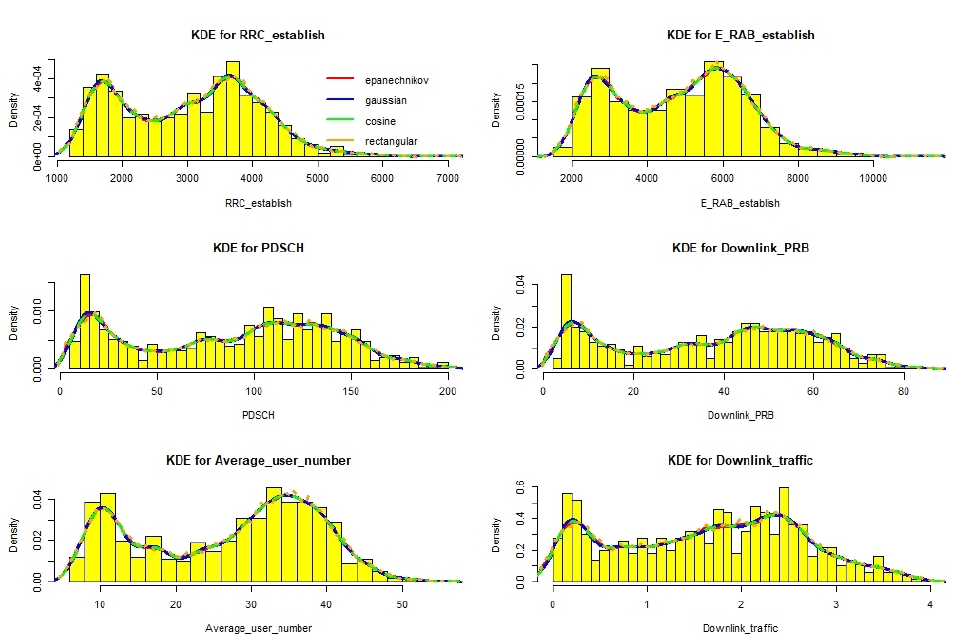
Figure 7. Kernel density estimation results for different KPI data.